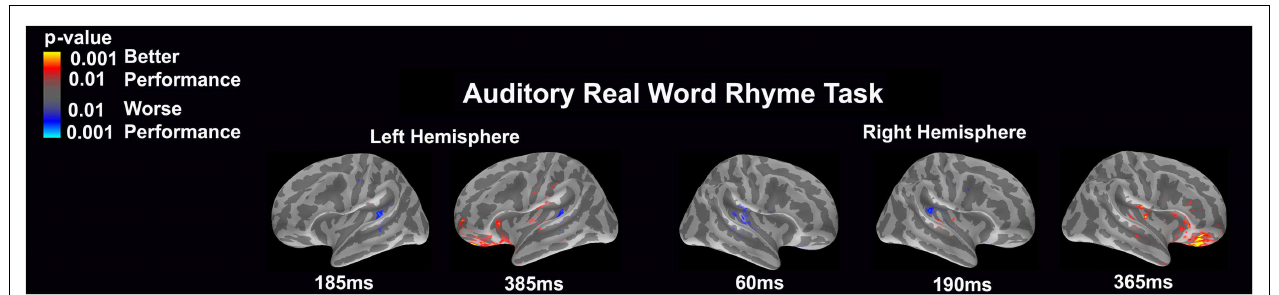
associated with worse performance. Performance was based on the individual participant’s real word reading ability as indexed by the scaled score on theWoodcock–Johnson III Letter–Word Identification subtest.